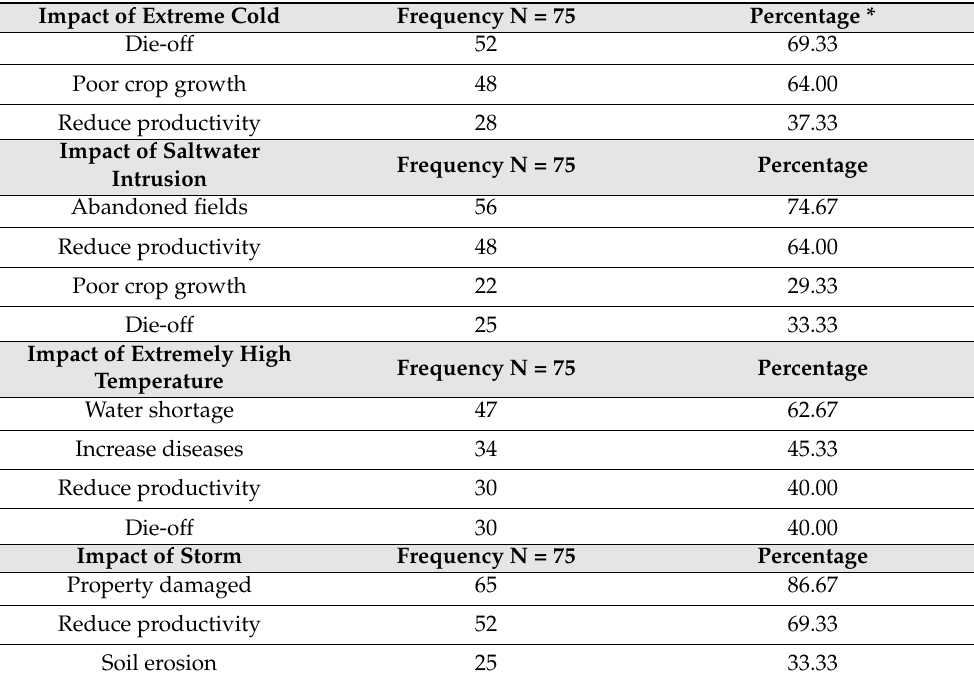
Table 8. Impacts of climate change on crop